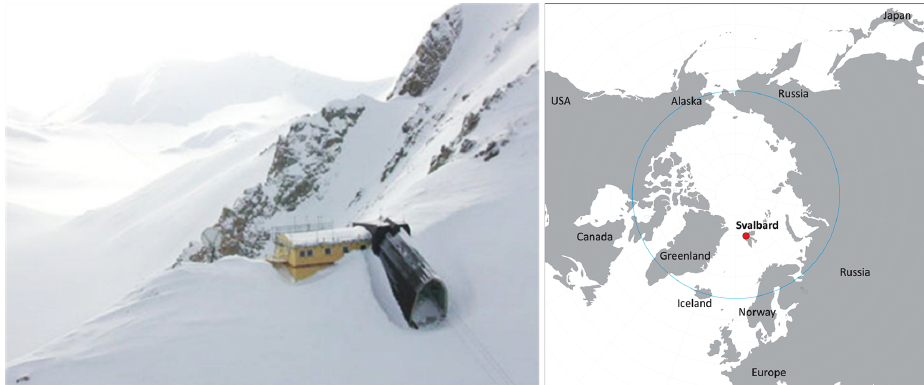
Figure 1. The Zeppelin observatory located at the Zeppelin Mountain (478m a.s.l.) close to Ny-Ålesund (Svalbard) (78 ◦ 54 0 N, 11 ◦ 53 0 E). The light-blue line on the map shows the Arctic